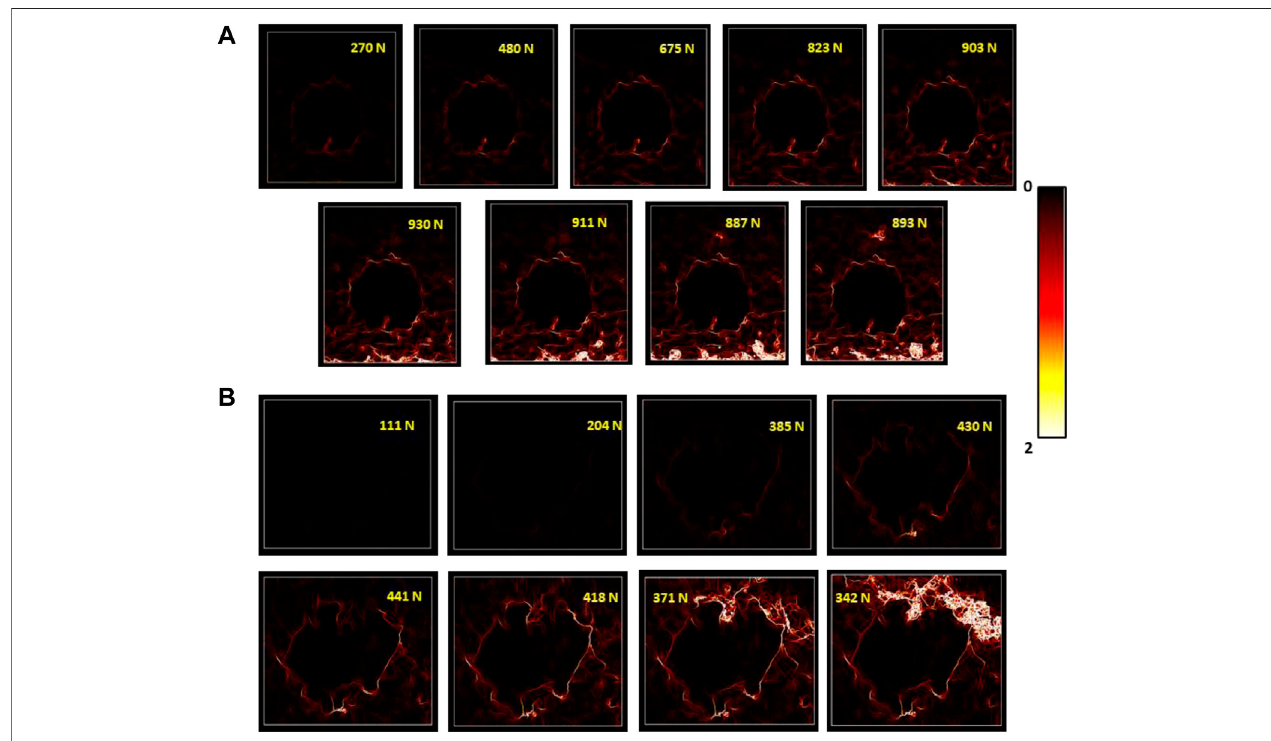
FIGURE5| Evolutionofequivalentstrain fi eldsobtainedfromtheDICmethodforconsecutiveloadingstepsfor (A) samplewithoutaballoonand (B) withaballoon.